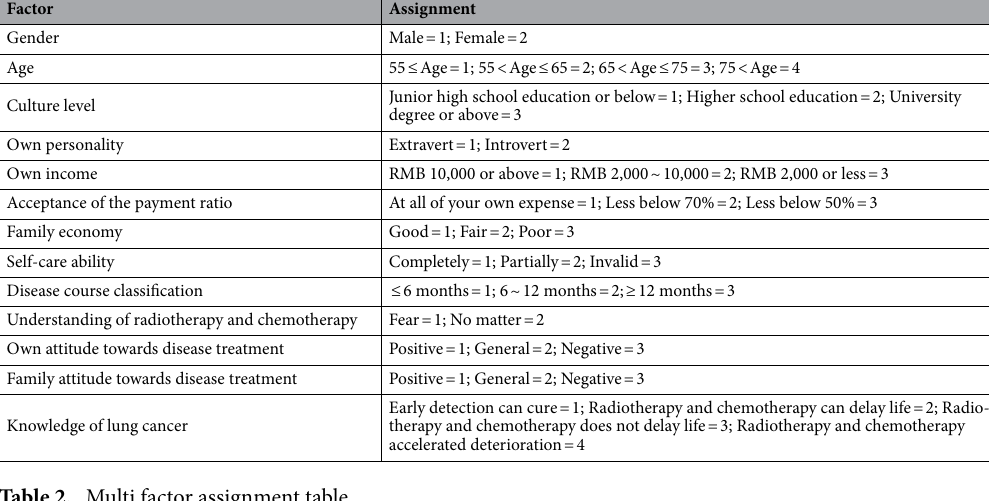
Table 2. Multi factor assignment table.